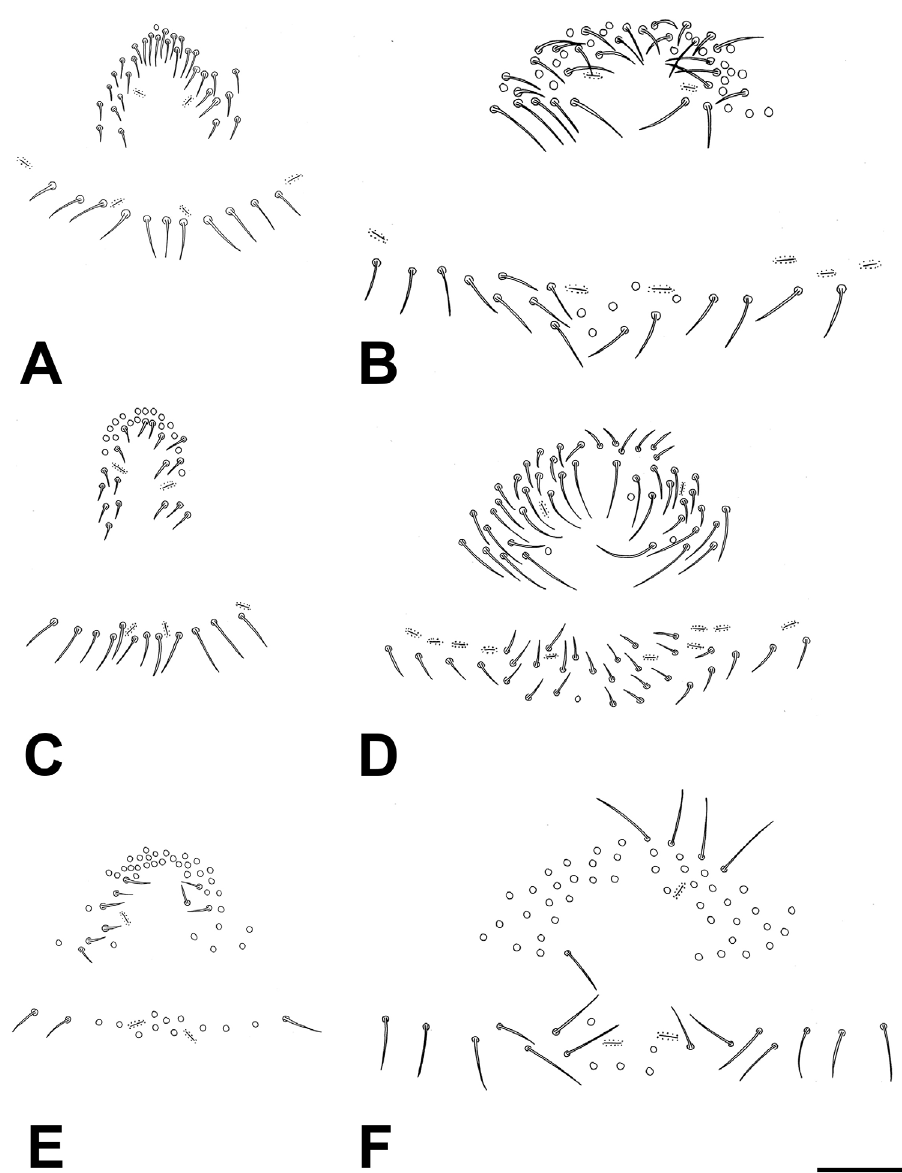
Figure 6. Variation in the setation of the genital area of Lasiochernes adults. A Female of L . cretonatus B Male of L . cretonatus C Female of L . jonicus D Male of L . jonicus E Female of L . pilosus F Male of L . pilosus . Scale lines: 0.1